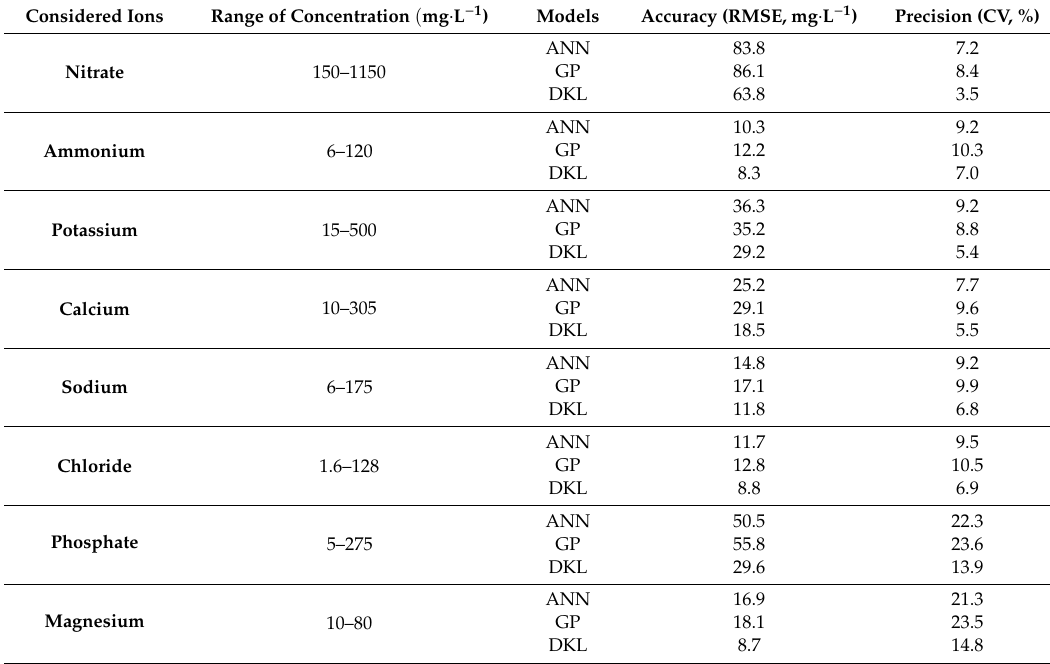
Table 8. Comparison of the predicted quality of the proposed models with the real hydroponic solution